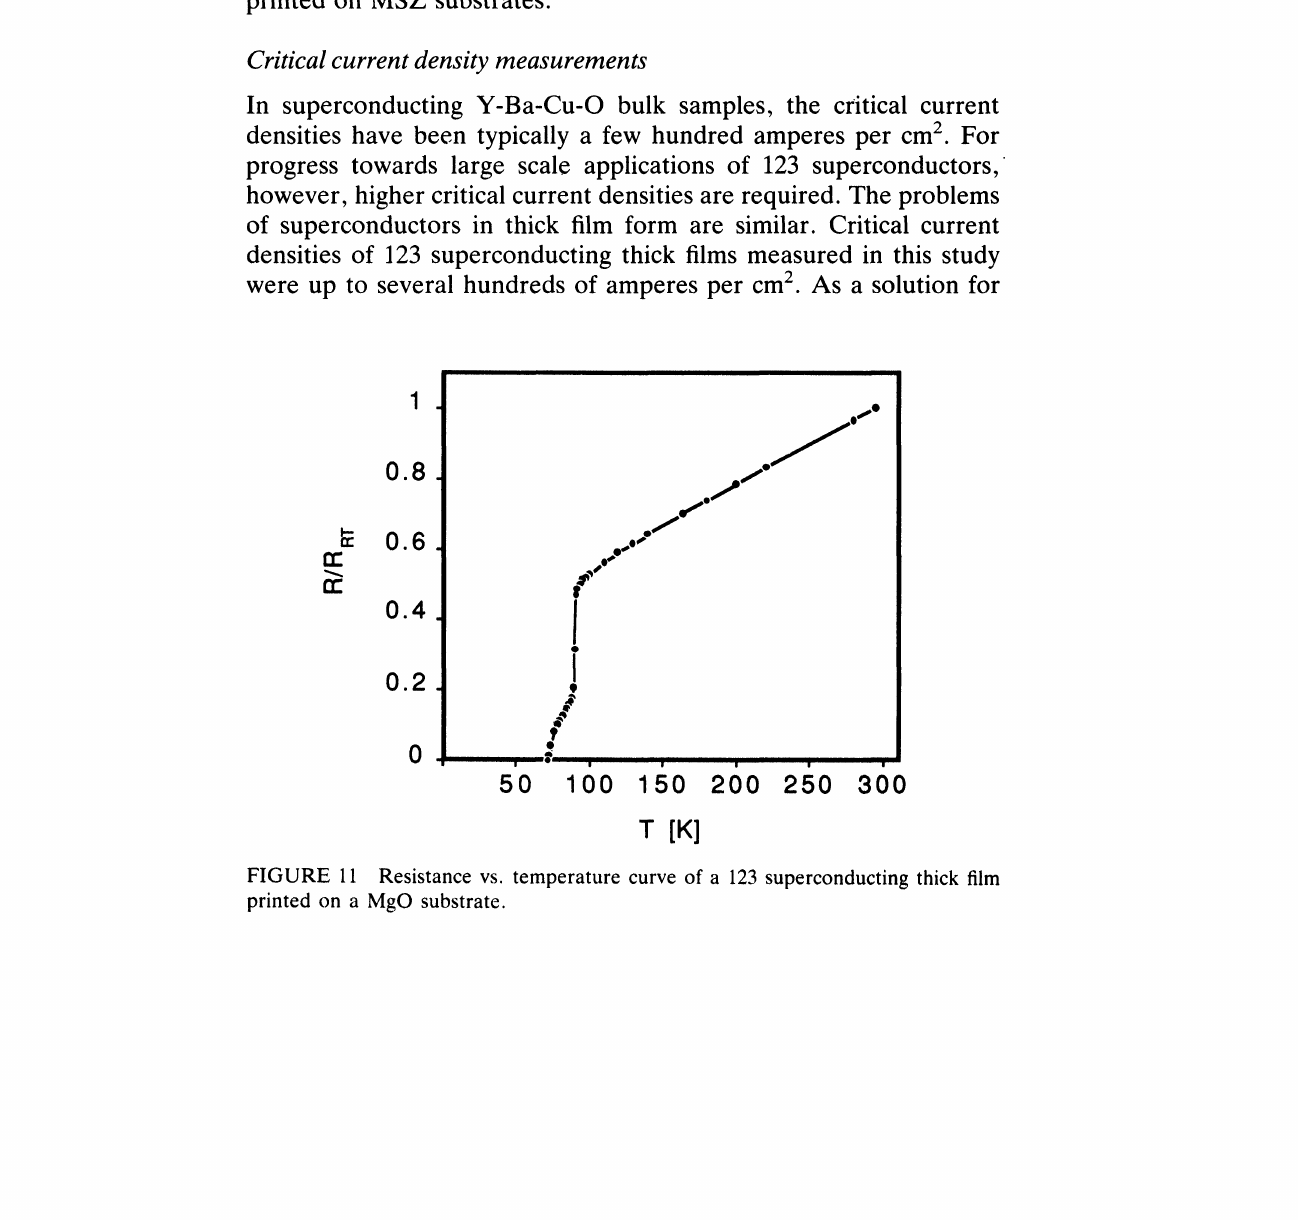
FIGURE 11 Resistance vs. temperature curve of a 123 superconducting thick film printed on a MgO